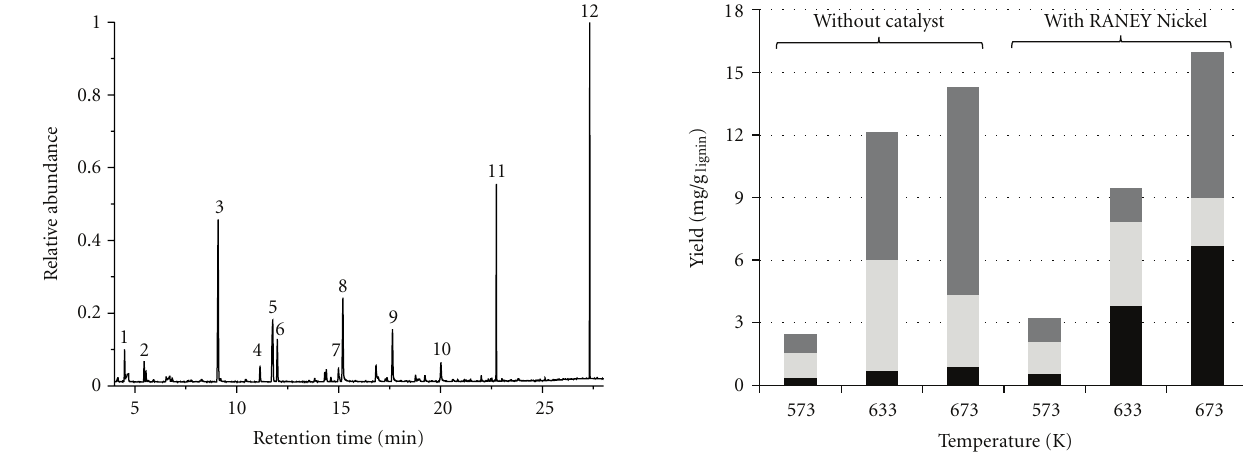
Figure 2: GC-FID Chromatogram of the organic fraction obtained from extraction of aqueous product after hydrothermal treatment of lignin for 30 min at 673 K with RANEY Nickel (chemical compounds are listed in Table 1).